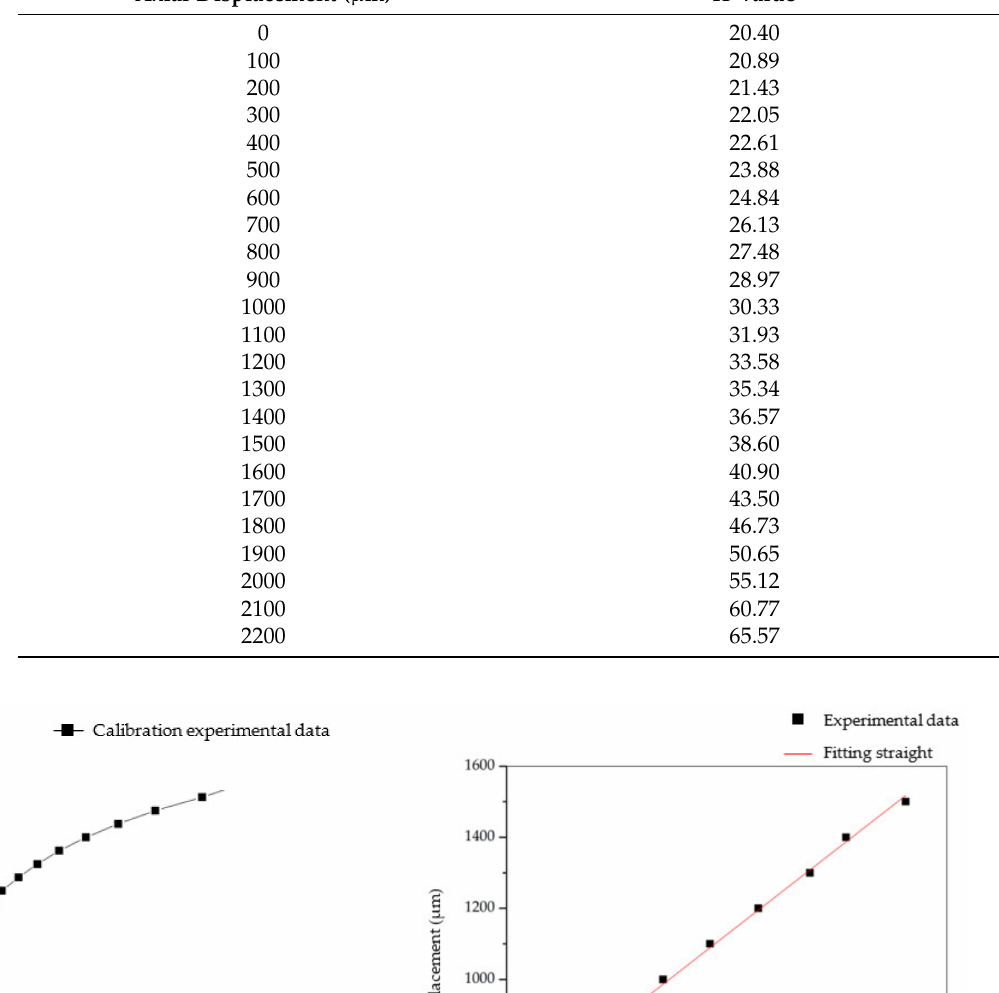
Table 2. Calibration result calculated using the date from the upper surface of the sample.